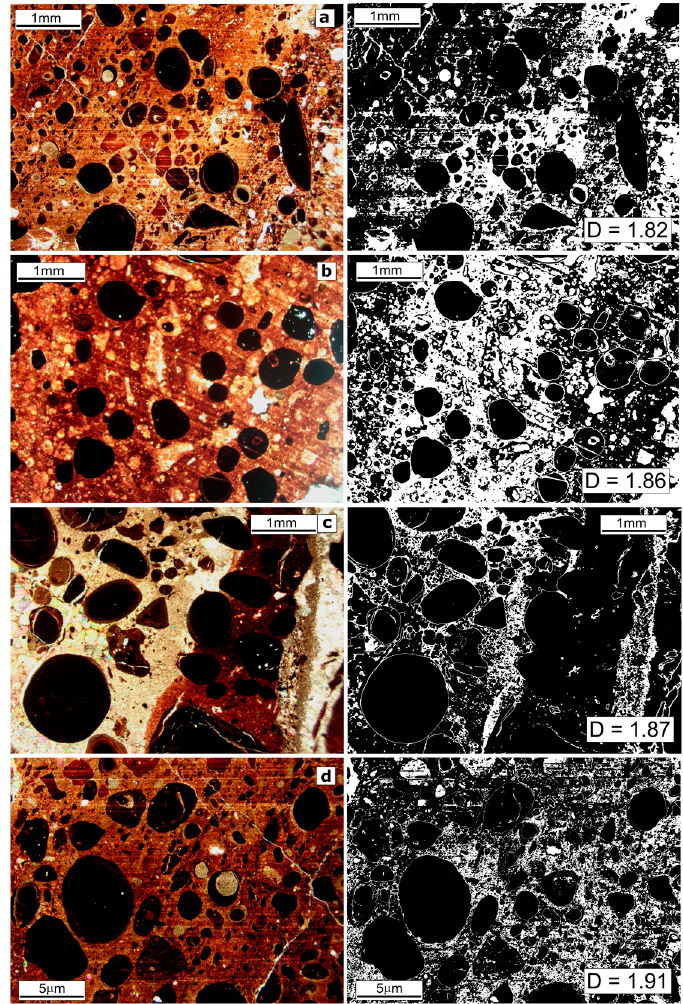
Figure 9. Binary images of selected samples for image analysis. The binarization of sample images was provided by the software Image J which produced black (ooids) and white (bauxite matrix) images. ( a ) binary image of the sample CS2; ( b ) binary image of the sample CS4, ( c ) binary image of the sample CU1, ( d ) binary image of the sample CU3.